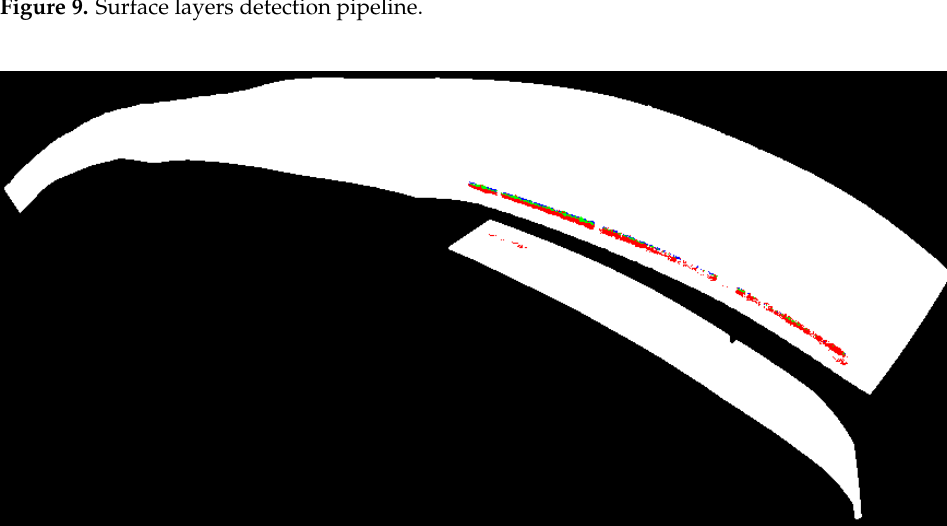
Figure 10. The detected surface layers.